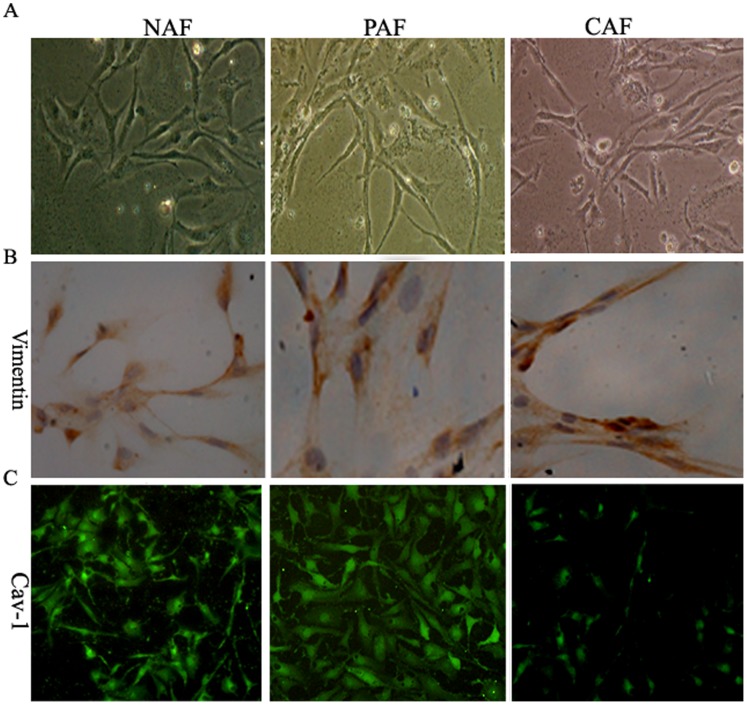
Immunodetection of Cav-1 protien in CAFs, PAFs, and NFs.
A: Cell morphological characteristic of CAFs, PAFs, and NFs (×100). Extracted CAFs from pancreatic cancer and PAFs and NFs from paracancerous tissue and non-cancerous partial pancreatectomy specimens. B: Different vimentin expression levels in stroma CAFs, PAFs, and NFs were assessed by immunohistochemistry (×200). C: Cav-1 protein expression in CAFs and NFs stained with FITC labeling-IgG antibody and analyzed by confocal microscopy. Cav-1 fluorescence signal in CAF is lower than in PAFs and NFs (×200). (CAFs) Cancer associated fibroblasts; (PAFs) Paracancerous associated fibroblasts; (NFs) Normal associated fibroblasts.